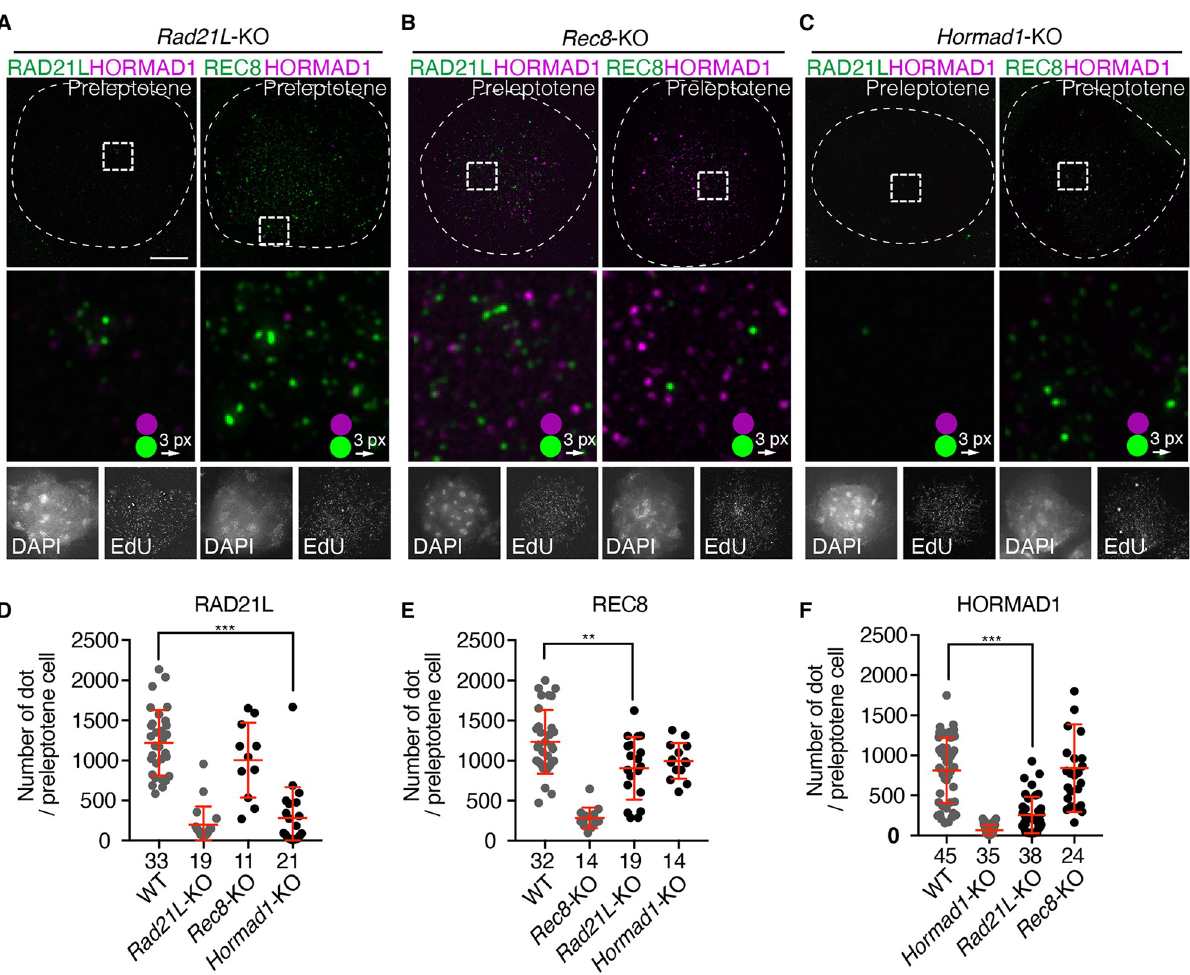
Fig 6. Meiotic cohesins are required for initial chromatin loading of HORMAD1 during early prophase. ( A—C ) Spread chromatin of preleptotene spermatocytes from Rad21L -KO (A) , Rec8 -KO (B) , and Hormad1 -KO (C) mice were immunolabelled for HORMAD1 (magenta), RAD21L (green) and REC8 (green). ( D-F ) Scatter plots show the number of immunolabelled HORMAD1 dots in a preleptotene cell. Red lines represent mean and SD. N: the number of the cells observed. Statistical significance was assessed by one-way ANOVA followed by Turkey’s multiple comparisons test with a single pooled variance. � : p < 0.05, ��� : P <